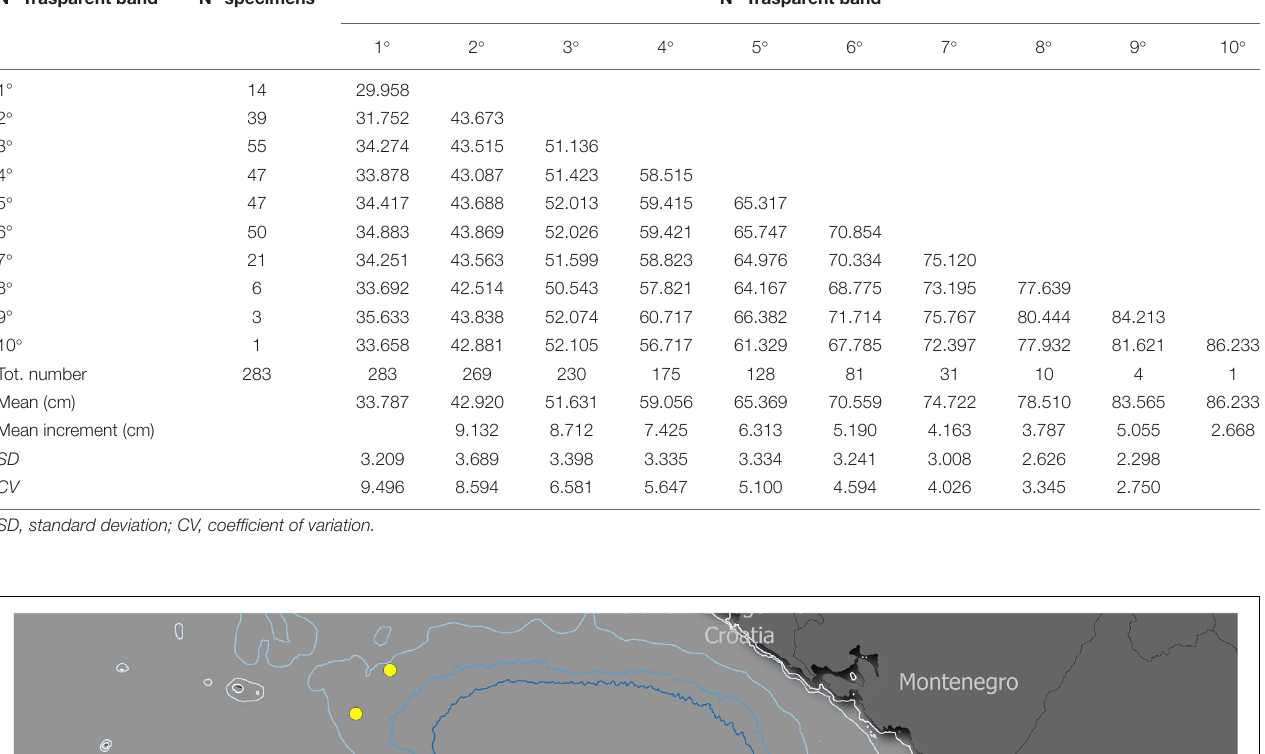
Frontiers in Marine Science |